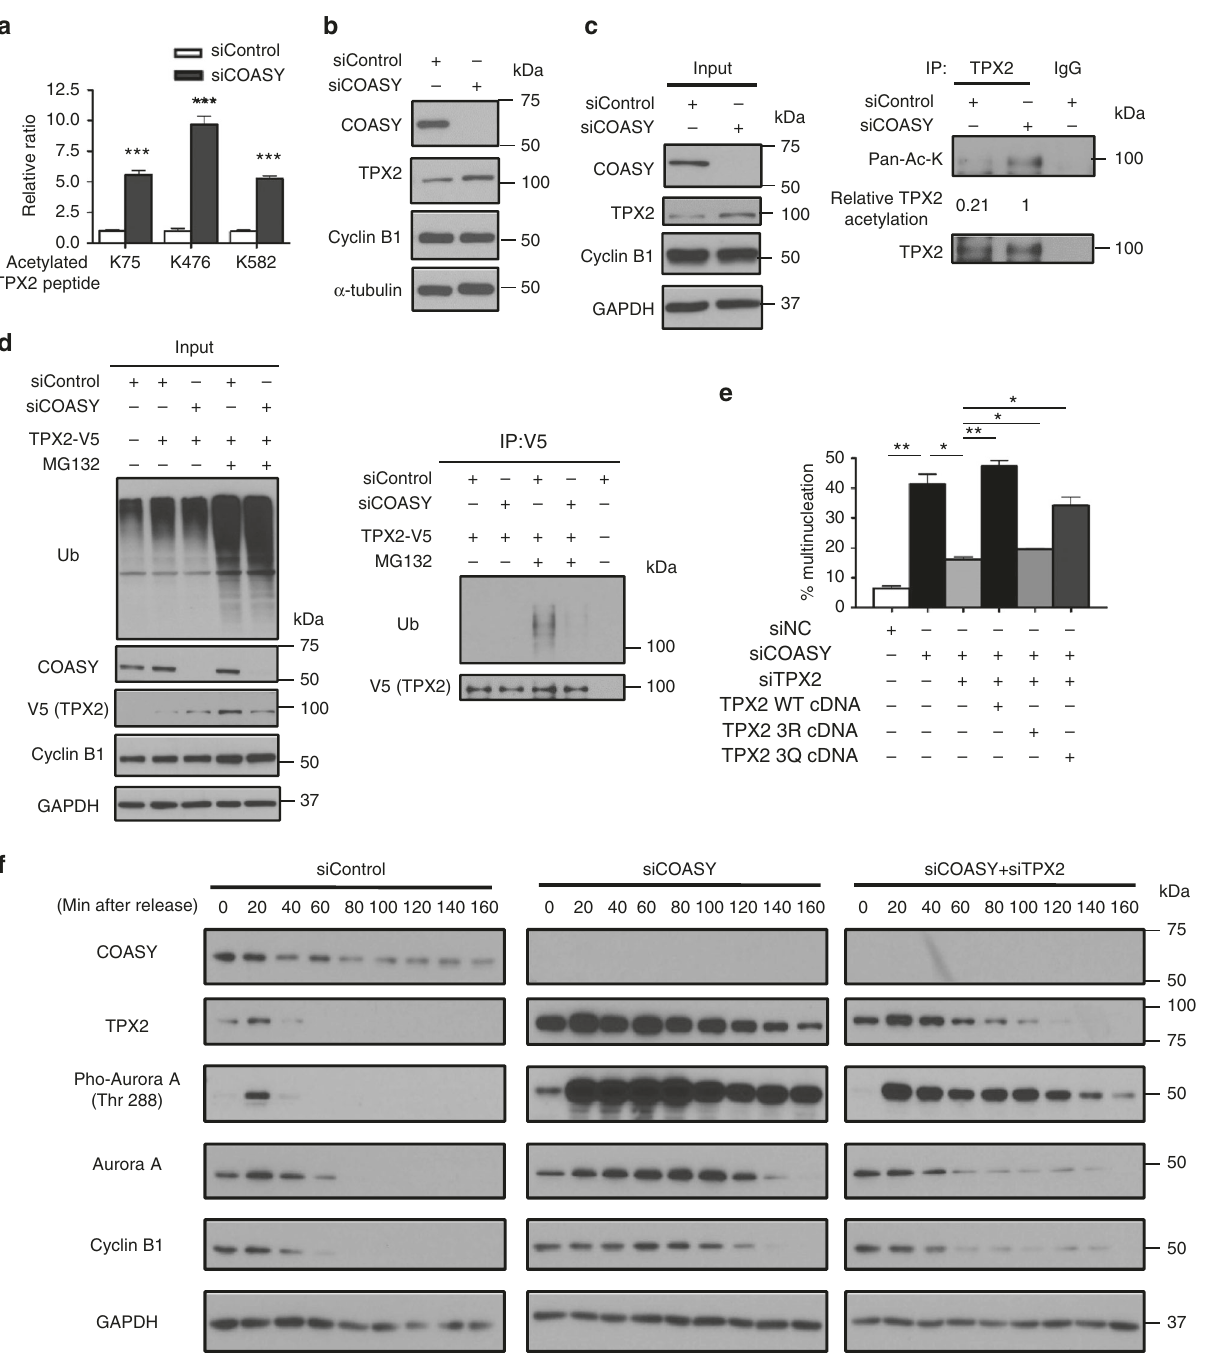
Fig. 3 TPX2 is the downstream effector of COASY leading to multinucleation and extended mitosis. a COASY knockdown increased three acetylated peptides (K75, K476, and K582) of TPX2 as determined by acetylome analysis. b COASY knockdown increased TPX2 protein level in A549 cells. c COASY knockdown increased the TPX2 acetylation in A549 cells. A549 cells enriched in early mitosis by thymidine-nocodazole block were transfected with control or COASY siRNA and probed with indicated antibodies The TPX2 in the cell lysates were then immunoprecipitated and blotted for pan-acetylated lysine antibody. d COASY knockdown decreased TPX2 ubiquitination in HEK-293T cells. HEK-293T cells were transfected with COASY siRNA and TPX2 cDNA. After MG132 treatment, TPX2 were immunoprecipitated and blotted for pan-ubiquitination antibody. e TPX2 protein expression level and acetylation on TPX2 regulated the percentage of COASY-dependent multinucleation. TPX2 knockdown rescued the multinucleation induced by COASY knockdown. Reintroducing wild type (WT) or acetylation-mimetic mutant (3Q), but not acetylation-de fi cient (3R), of siRNA-resistant TPX2 cDNA recapitulated multinucleation phenotype. Multinucleation was determined as described in the legend to Fig. 1. f COASY knockdown triggered increased Aurora A Thr 288 phosphorylation and extended mitosis by the elevation of TPX2. A549 cells were synchronized by thymidine-nocodazole block and released in fresh media for the indicated time (in min). COASY knockdown increased TPX2 expression and delayed its decline during from 40 min (control) to >160min. COASY knockdown also delayed the inactivation of Aurora A and degradation of cyclin B1, indicating extended mitosis. The extended mitosis caused by COASY knockdown can be abolished by simultaneous TPX2 knockdown. Bars show standard error of the mean. * p <0.05, ** p <0.01, *** p < 0.001, two-tailed Student ’ s t -test, n = 3